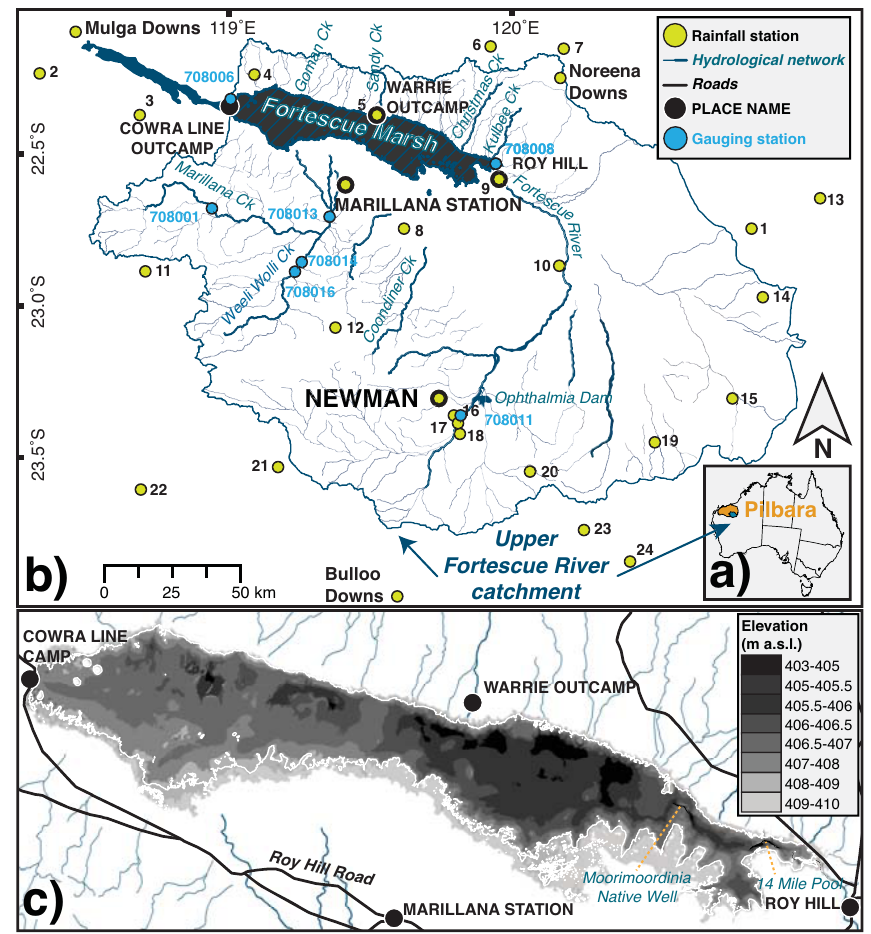
Figure 1. The (a) Pilbara region in northwest Australia, (b) upper Fortescue River catchment and river network (blue lines; www.water.wa. gov.au), including the Fortescue Marsh’s floodplain area used in this study (black hatched section; < 410ma.s.l. extracted from a 1s DEM-H, Geoscience Australia, 2011), stream gauging stations (blue circles, see full list in Appendix A, Table A1; WIN, 2014) and meteorological stations (green circles, see full list in Appendix A, Table A2; http://www.bom.gov.au/climate/data/) and (c) elevation of the study area (0.1m vertical accuracy (RMS) LiDAR Survey DEM; Fortescue Metals Group Ltd, 2010) with roads and place name (black lines and circles; Geoscience Australia, 2001). Generated in ArcMap v.